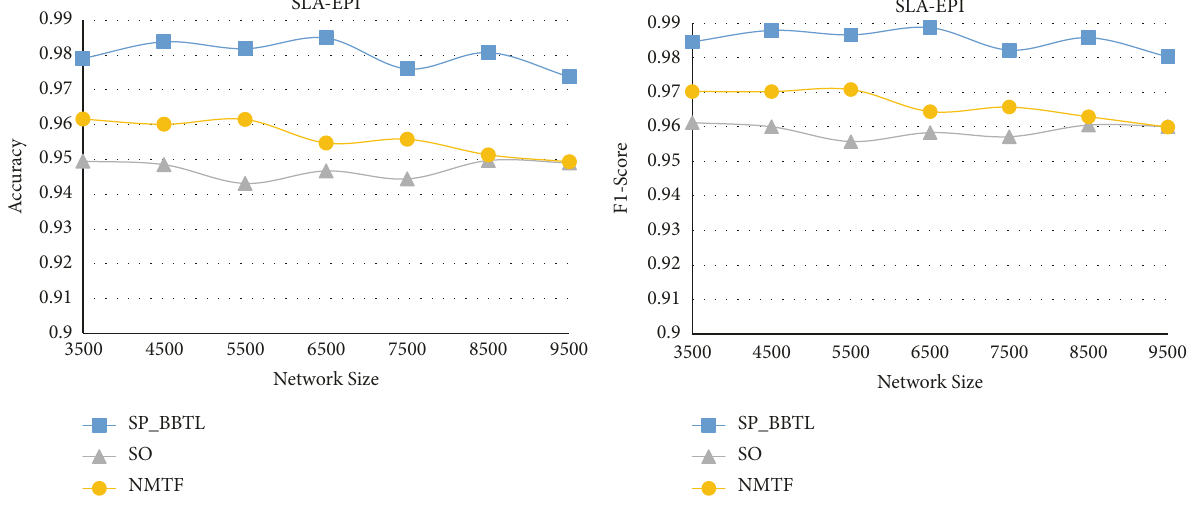
Figure 3: Sign prediction performances with the various network sizes. Table 1: Detail information of the experimental